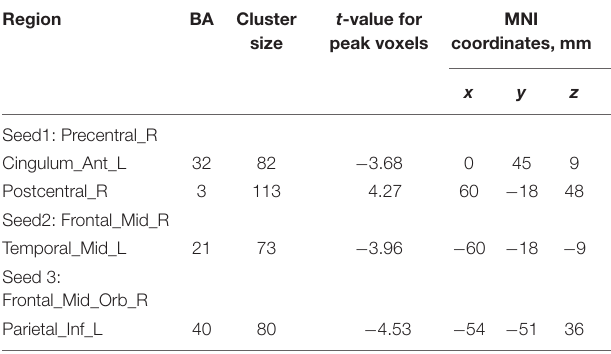
TABLE 5 | Brain regions showing significant FC differences between CAI patients and healthy controls. Region BA Cluster